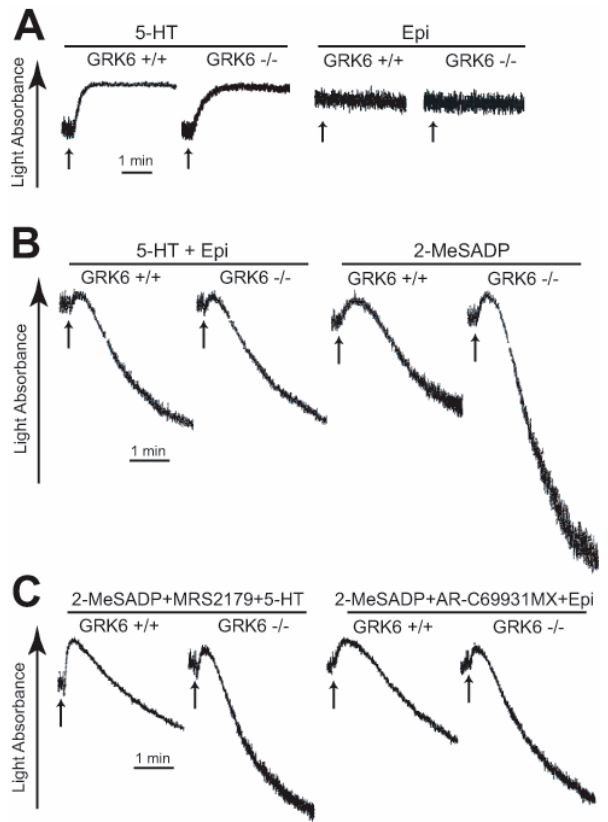
Figure 3. GRK6 selectively regulates P2Y 1 and P2Y 12 receptor-mediated platelet responses. Platelets from GRK6 +/+ and GRK6 − / − mice were stimulated with ( A ) 20 µM 5-HT and 100 µM epinephrine, ( B ) 20 µM 5-HT + 100 µM epinephrine and 30 nM 2-MeSADP, and ( C ) 30 nM 2-MeSADP + 100 µM MRS2179 + 20 µM 5-HT and 30 nM 2-MeSADP + 100 nM AR-C69931MX + 100 µM epinephrine, and